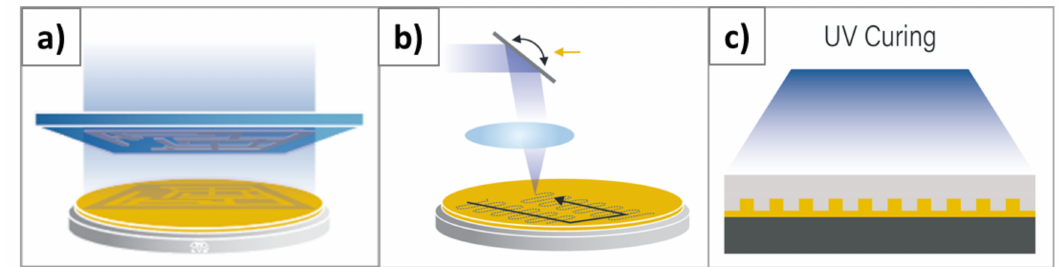
Figure 1. Schematic drawing of Ultraviolet (UV)-based lithographic techniques: ( a ) Optical lithography with a shadow mask, ( b ) direct writing, ( c ) UV-Nanoimprint Lithography